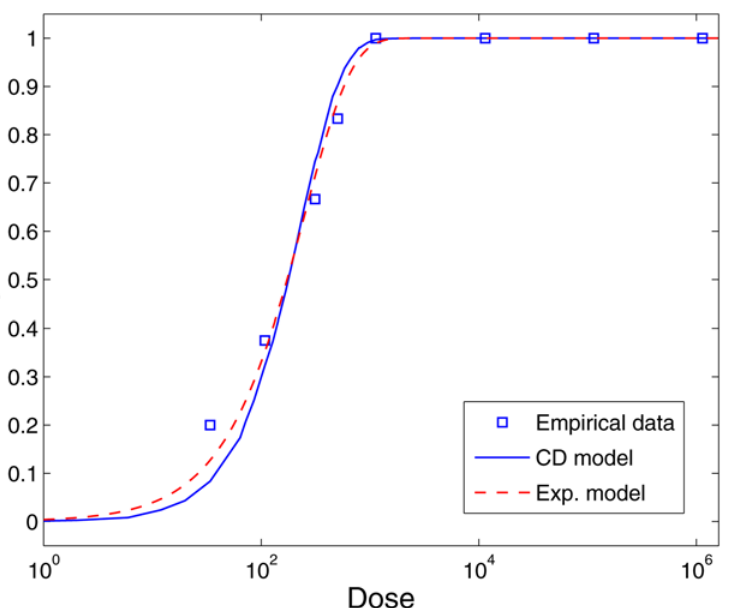
Figure 5. Dose-response curves based on the Exponential Model ( EM ) and the Cumulative Dose model ( CD ) compared to the experimental dataset for Cryptosporidiumparvum(squares). The estimated parameters are ^ rr ~ 4 : 005 | 10 { 3 for the Exponential model [30] and h P , d P , a I , c I , d I , l I f